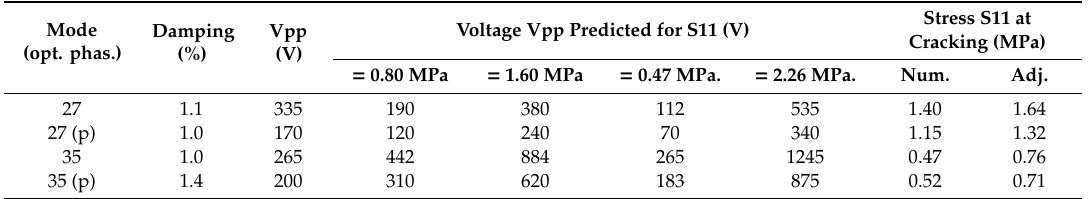
Table 15. Stress S11 and voltage prediction by the numerical model compared to experimental results for cracking modes.